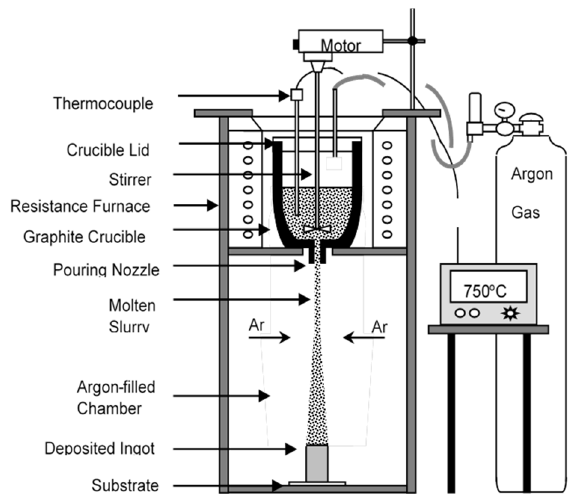
Figure 2. Schematic diagram of disintegrated melt deposition technique [95].